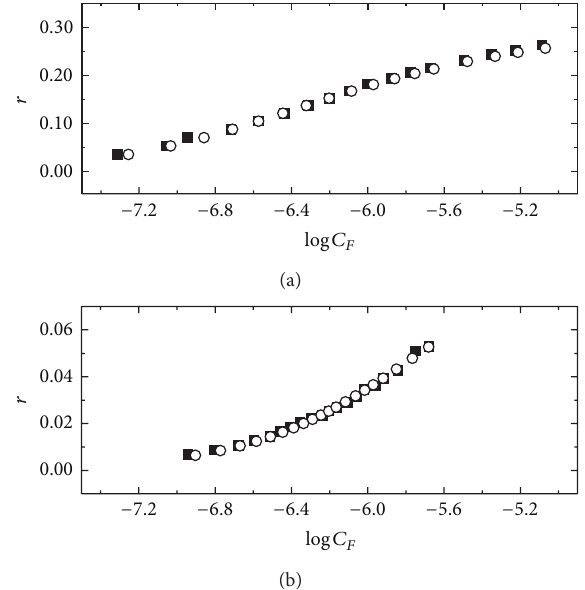
Figure 4: The rate number 𝑟 (ratio of bound ligand concentration to DNA concentration) as a function of the free ligand concentration for ActD-DNA titration. The squares and circles represent the classical and SVD model fitting procedures,